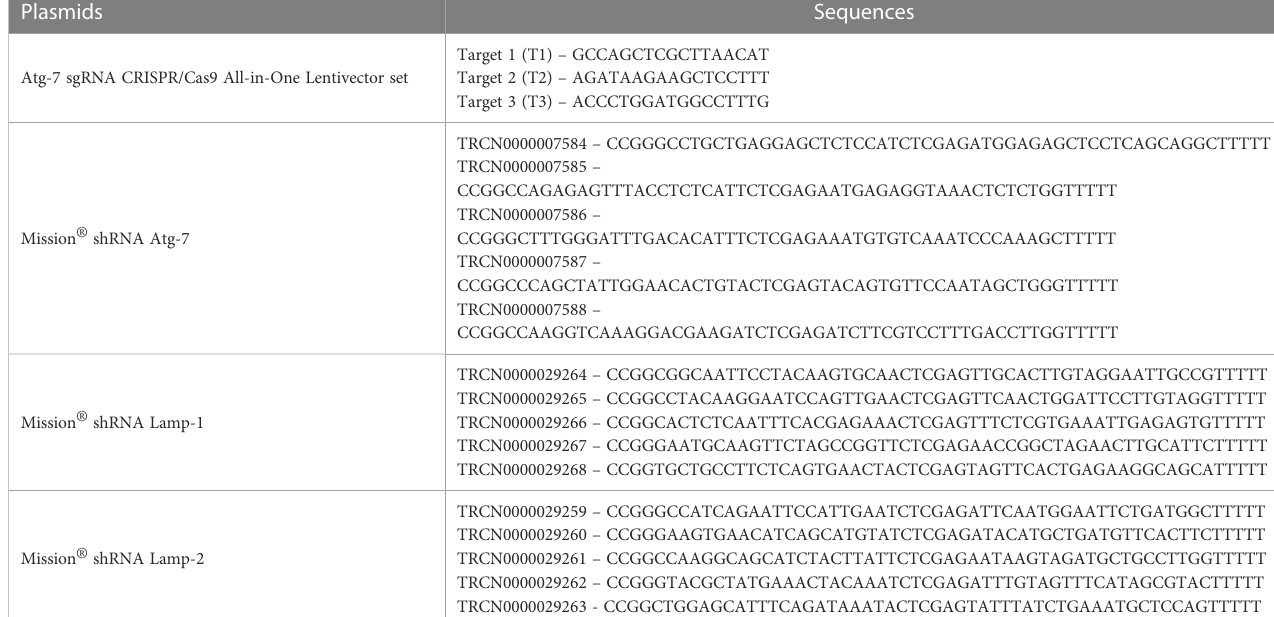
TABLE 1 Sequences of shRNA and CRISPR plasmids.